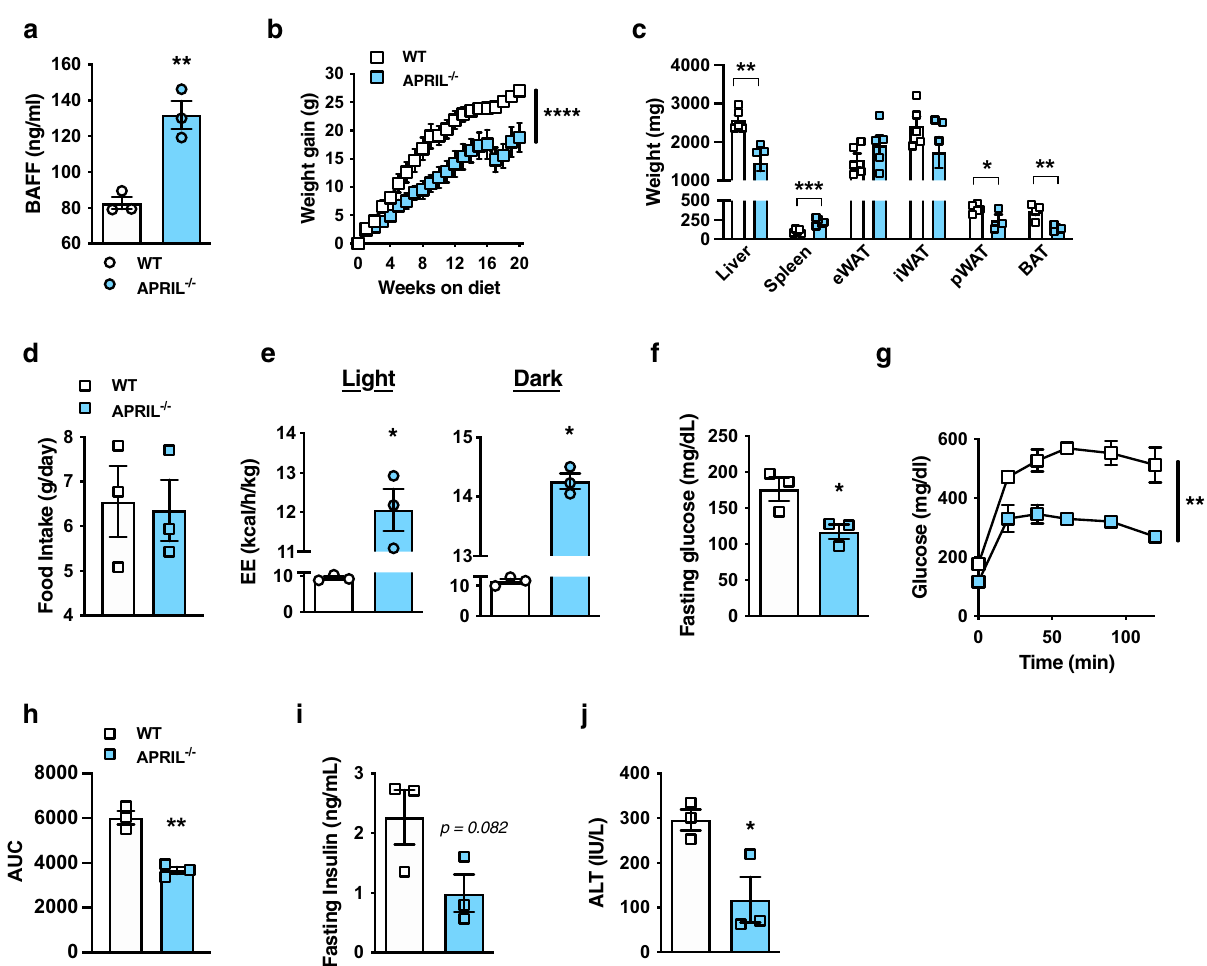
Fig. 5 APRIL-de fi cient mice are protected from obesity development. a – j WT and APRIL − / − mice were fed HFD for 20 weeks. a Systemic BAFF concentration quanti fi ed by ELISA. b Weight gain. c Tissue weight distribution as indicated at time of harvest. d Food Intake. e Combined energy expenditure at 16 weeks of HFD analyzed by TSE Phenomaster system. f Fasting glucose at 20 weeks of HFD. g GTT at 14 weeks of HFD. h AUC. i Fasting insulin at 20 weeks of HFD. j Systemic ALT at 20 weeks of HFD. k Weight gain of WT, BAFF − / − , APRIL − / − , or BAFF − / − /APRIL − / − mice fed HFD for 20 weeks. a – j Representative of three independent experiments, n = 6-7/condition. a – j For bar and line graphs, data represent mean ± SEM. a , c – f , i – j Unpaired two-tailed Student ’ s t test. * p < 0.05, ** p < 0.01, *** p < 0.001. b , g – h Area under the curve. ** p < 0.01, **** p < 0.0001. Source data are provided as a Source data fi (Fig. 7a) and induced the mRNA expression of LIPE and